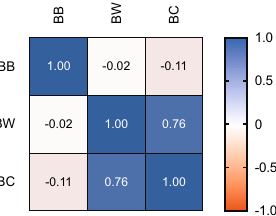
Figure 4. Multivariant correlation analysis of chemical compounds and their concentrations from the air-entrained chemical cues of beehive with bees (BB), beehive without bees (BW) and beehive with conspecifics (BC) . The analysis found that the chemical compounds and their concentrations from BW and BC were significantly